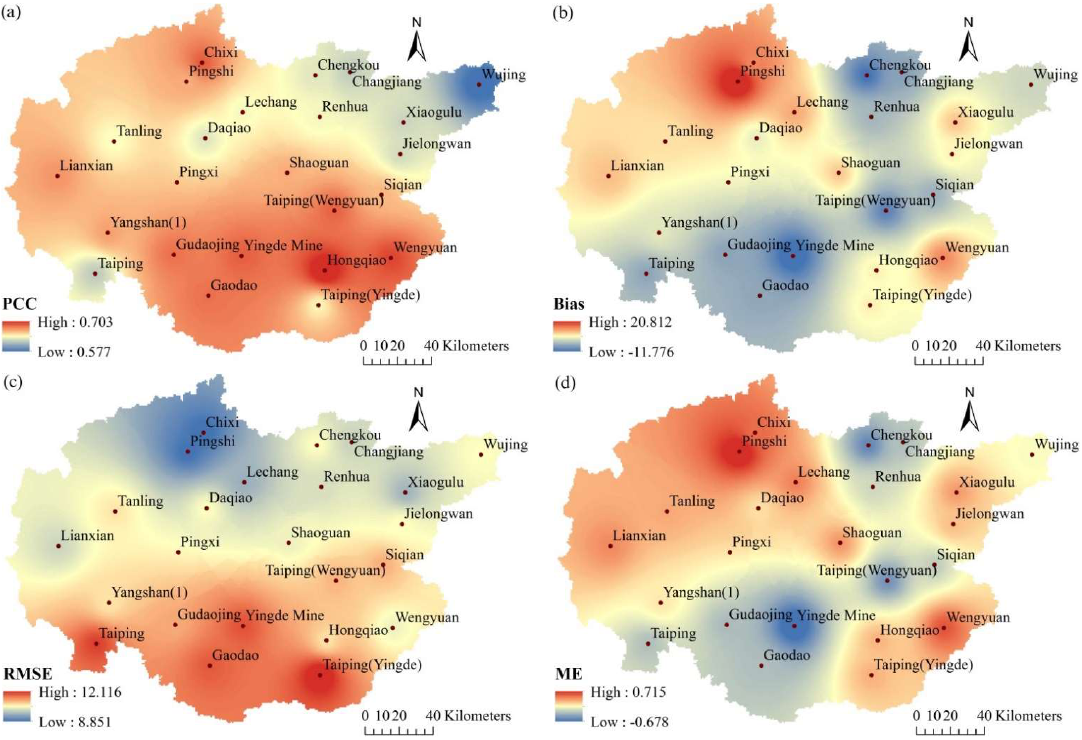
Figure 3. Spatial distributions of the four quantitative statistical indices: ( a ) PCC; ( b ) Bias; ( c ) RMSE; and ( d ) ME.